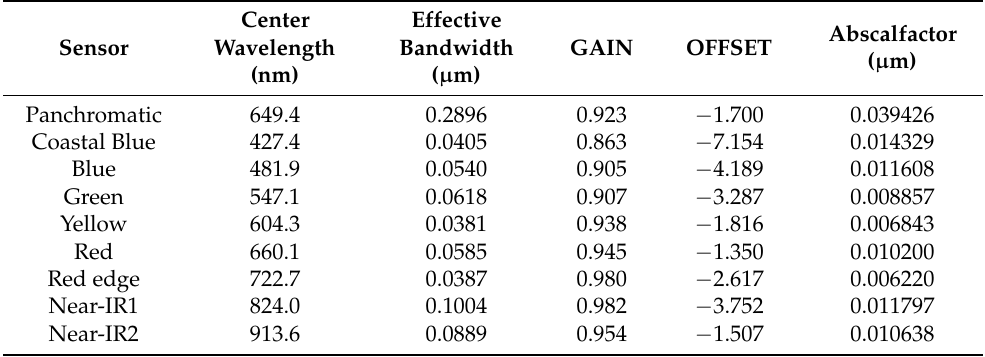
Table 4. Spectral bands [89]. Table 4. spectral bands [89].